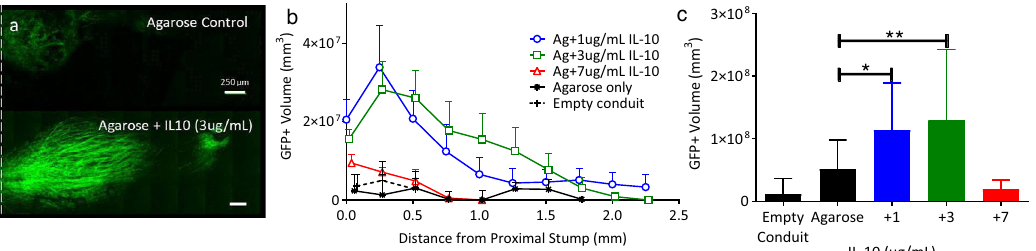
Fig. 8 Transient immunomodulation in rats promotes dose-dependent axon extension. a Representative fl attened z-stacks of regenerative bridges 21 days conduit repair. Bridges shown are agarose (ag) only or ag + IL10 (3 µg/mL). The White dashed line denotes the proximal stump. b GFP + axons per 250 μ m contiguous ROI extending from the proximal stump. c Dose-dependent effect of exogenous IL10 with signi fi cantly increased axonal extension at 1 and 3 µg/mL (Dunnets to agarose only, P < 0.05) but not 7 µg/mL. GFP expression depicted as total GFP + axon volume. Data are mean and standard error (s.e.). n = 6 – 8 animals per group, male and female.